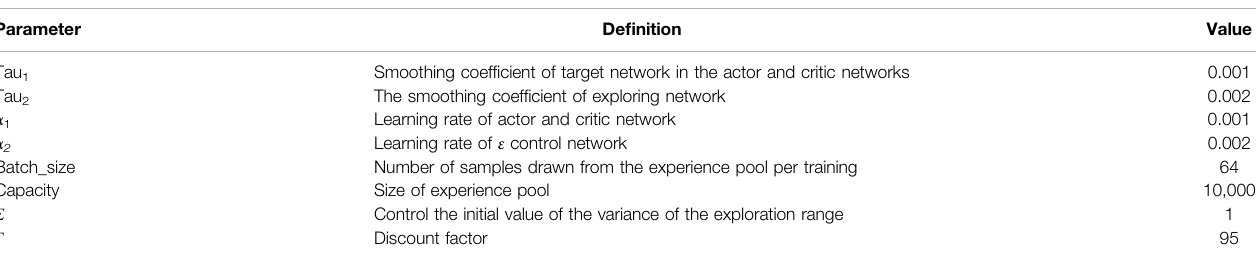
TABLE A1 | Parameter setting and description of DDPG